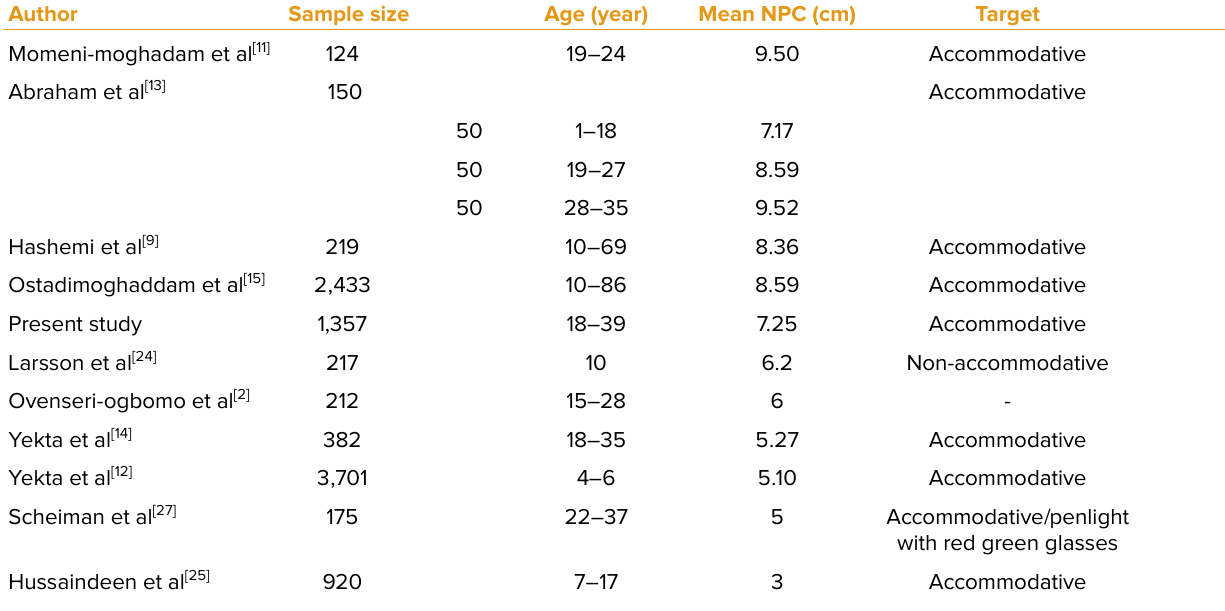
Table 2. The near point of convergence values reported by various